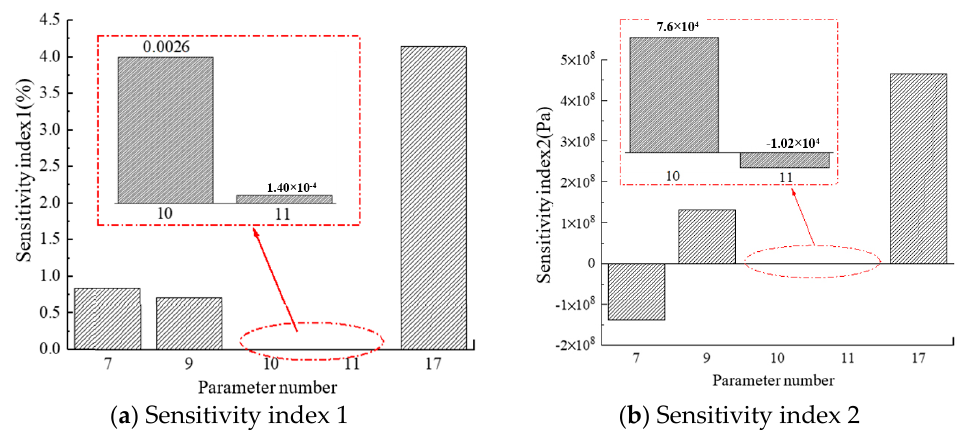
Figure 13. The change of x 8 with feedback part parameter varieties by 10%.